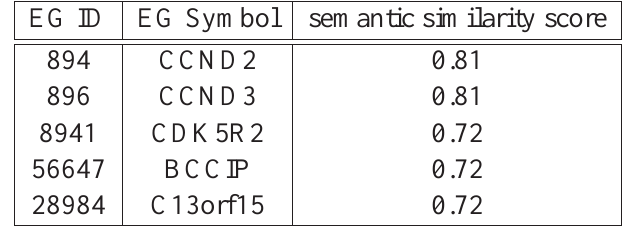
Table 1: Wang’s method [32] semantic similarity scores using the GO Biological Processes: the top 5 ranked genes are